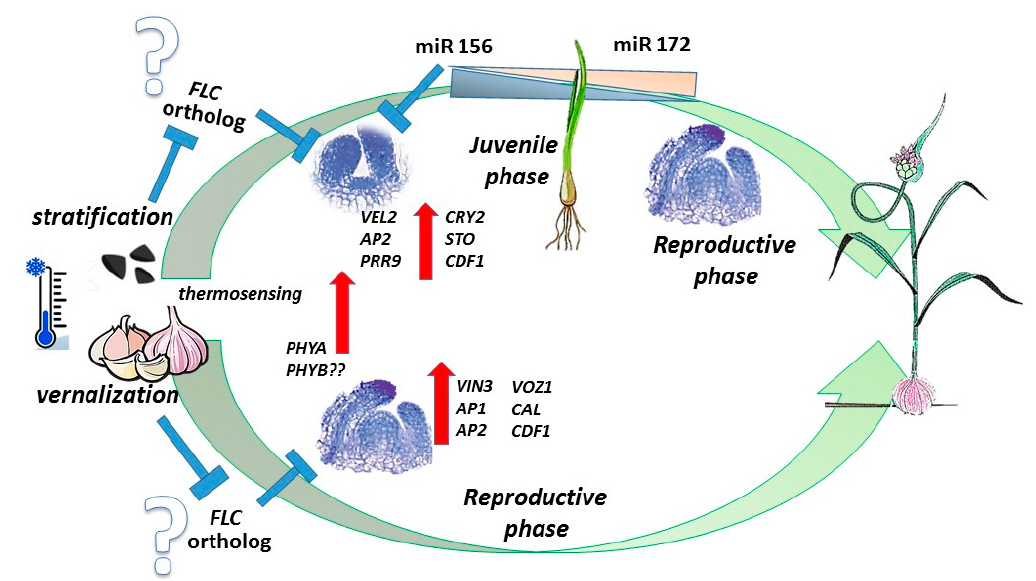
Figure 9. Effect of cold period on seeds (stratification) or bulbs (vernalization) of Allium sativum. Putative flower repressor(s) ( FLC orthologs) are downregulated by cold in both embryonic and adult meristems. In seedling development, acquisition of flowering competence depends on the miR156-miR172 cascade [2] and meristem enlargement, while in bud development the meristem is ready for phase transition to flowering [63].